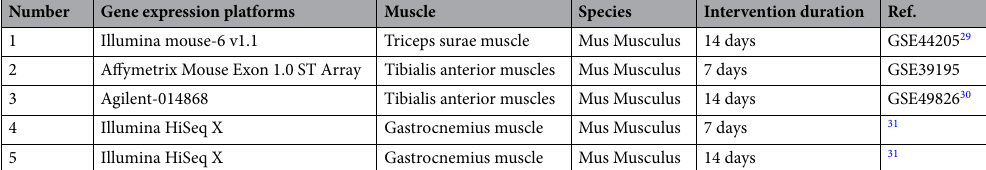
Table 1. Description of publicly available data sets used in the meta-analysis. Ref